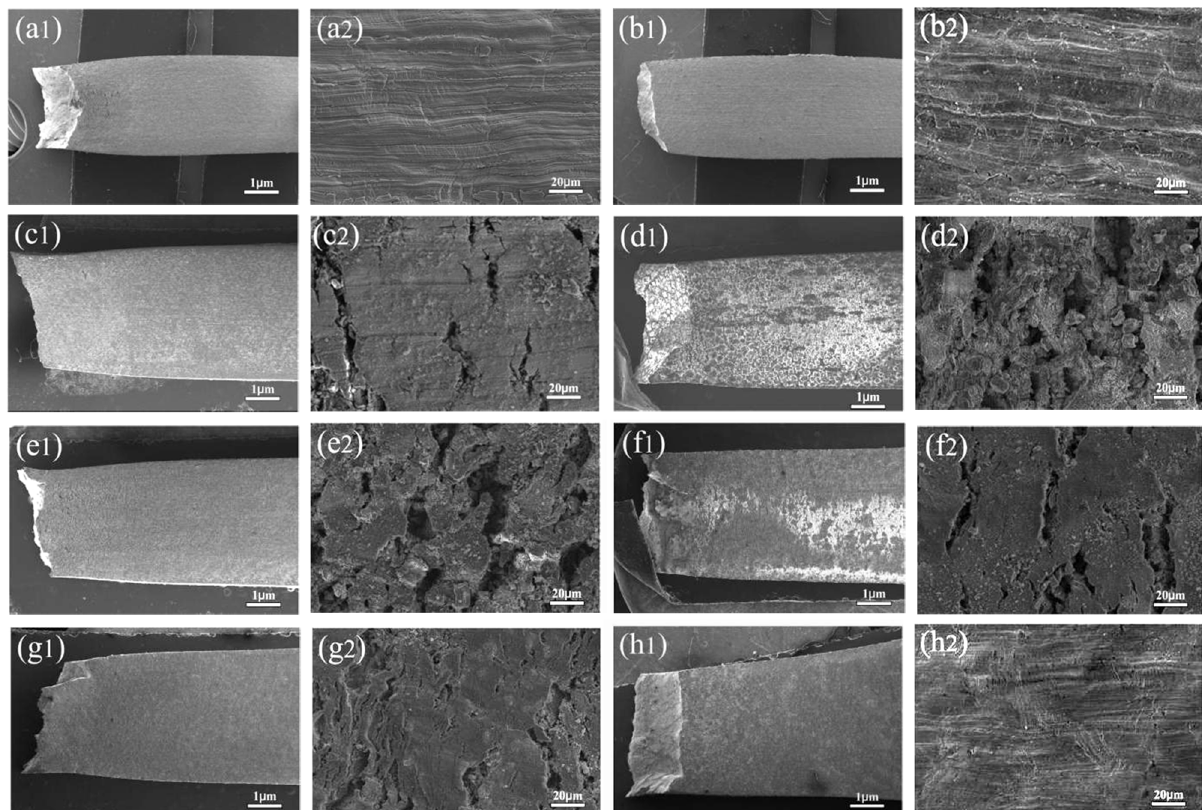
Figure 8: The SSRT fracture pro fi le of the sample in air and di ff erent Cl − concentration media: a1 – h1: macroscopic; a2 – h2: microscopic; ( a ) air; ( b ) 3.5% NaCl; ( c ) 7% NaCl; ( d ) 10.5% NaCl; ( e ) 14% NaCl; ( f ) 17.5% NaCl; ( g ) 21% NaCl; and ( h ) 24.5%